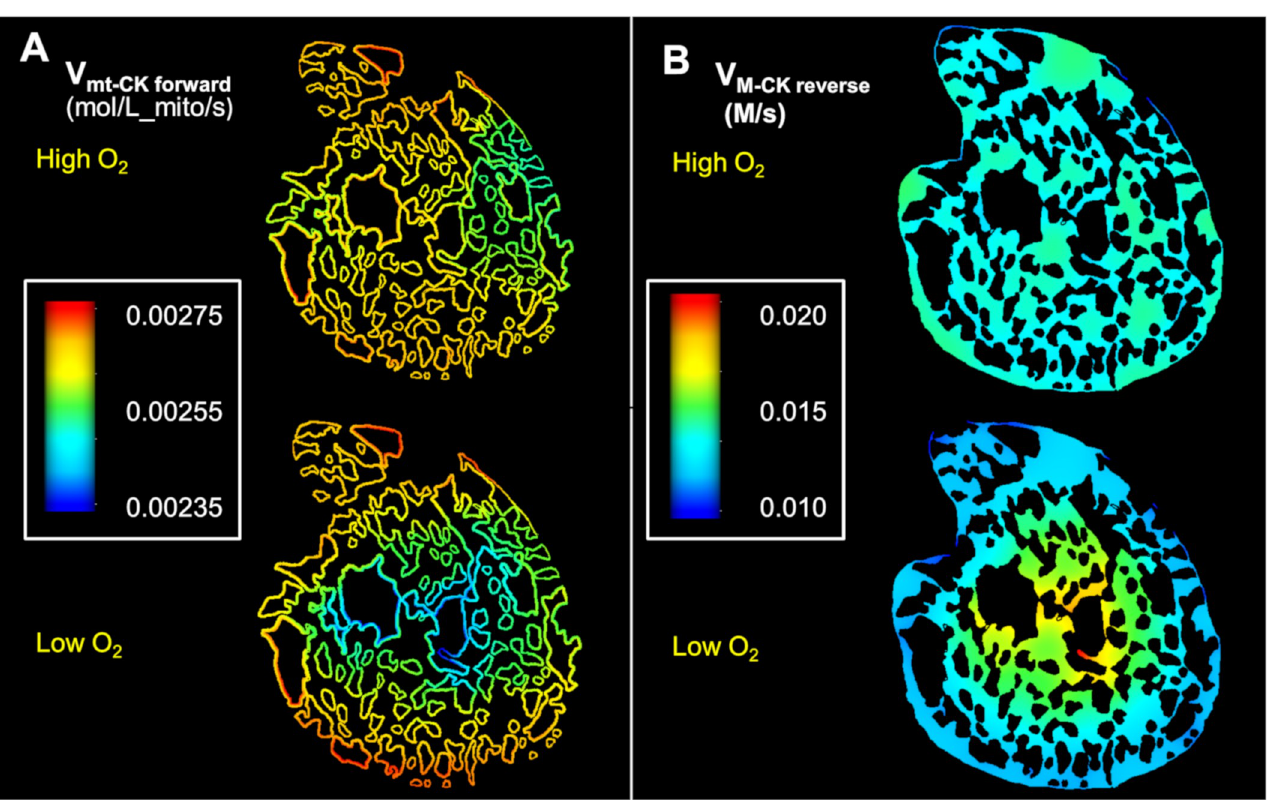
Fig 9. Spatial variation in rates of CK enzymatic reactions involved in phosphocreatine shuttle under normoxia and hypoxia. All the figures were generated by using same colour spectrum range. (A): Steady state profiles of reaction rates of mitochondrial mtCK in forward direction (ATP + Cr ! PCr + ADP) (B): Steady state profiles showing reaction rates of myofibrilar MCK in reverse direction (PCr + ADP ! ATP + Cr).